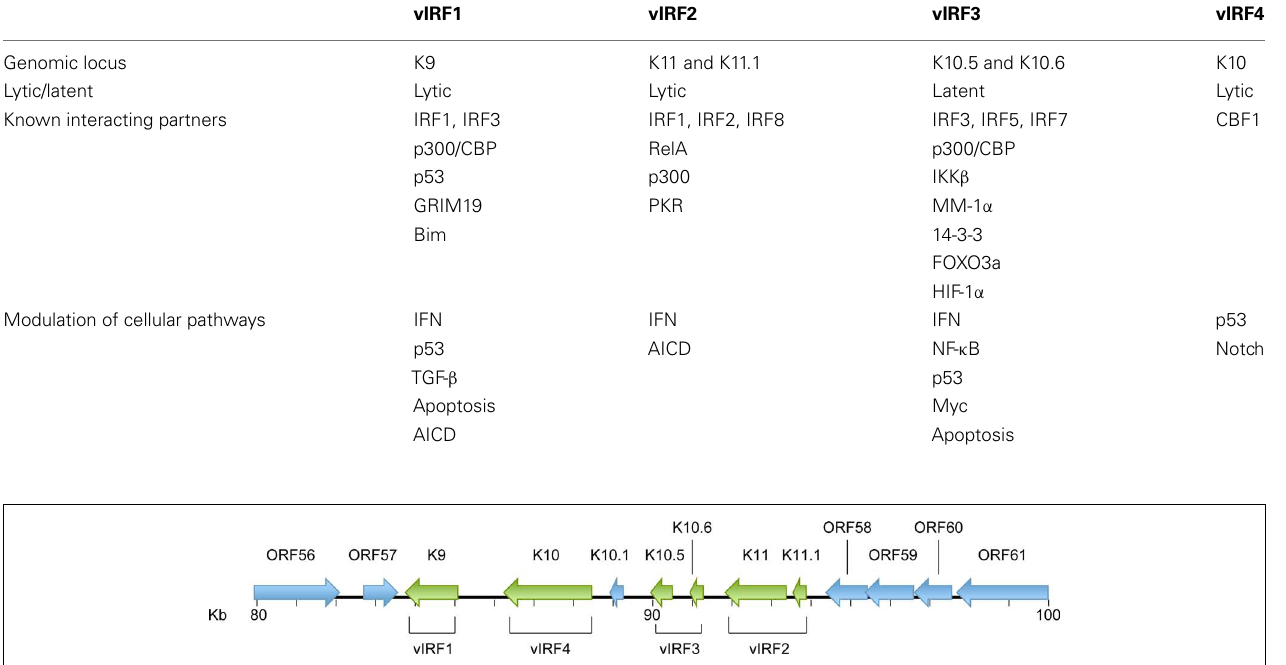
Table 1 | Summary of the location, expression, cellular binding partners, and cellular pathways modulated by the KSHV vIRFs.